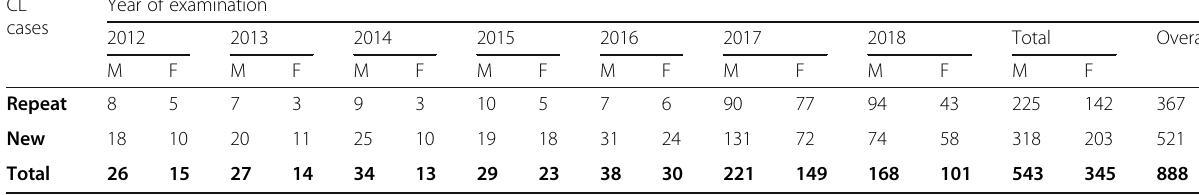
Table 3 New and repeat CL cases among patients who were treated at the BMH Dermatology Department from 2012 to May 2018 CL